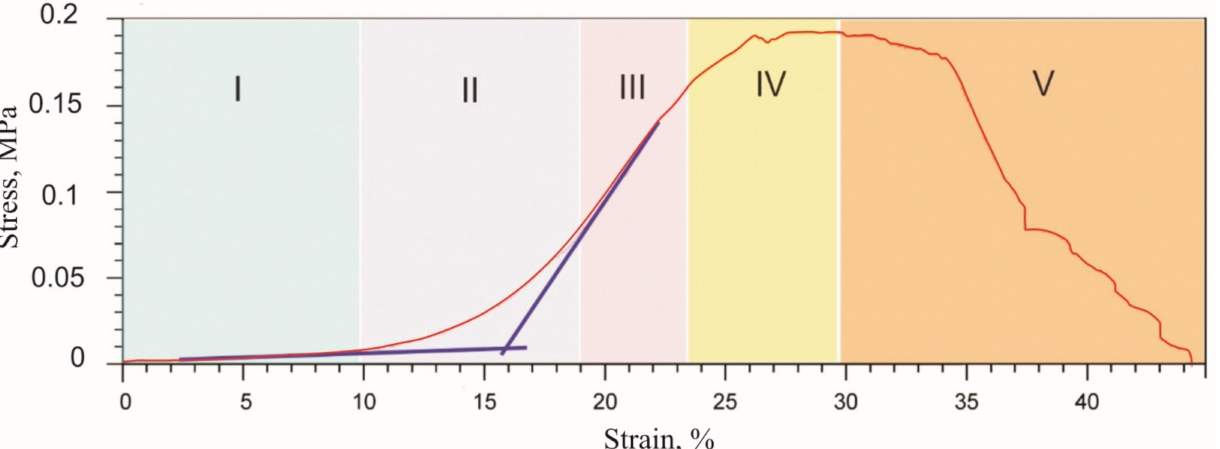
Figure 5. Engineering stress-strain curve of a single tension cycle before rupture of soft biological tissue. I—the initial linear region with low elastic modulus; II—the middle transition region of nonlinear deformation; III—the linear region with high elastic modulus; IV—yield region; V—rupture of the fibrous structure.